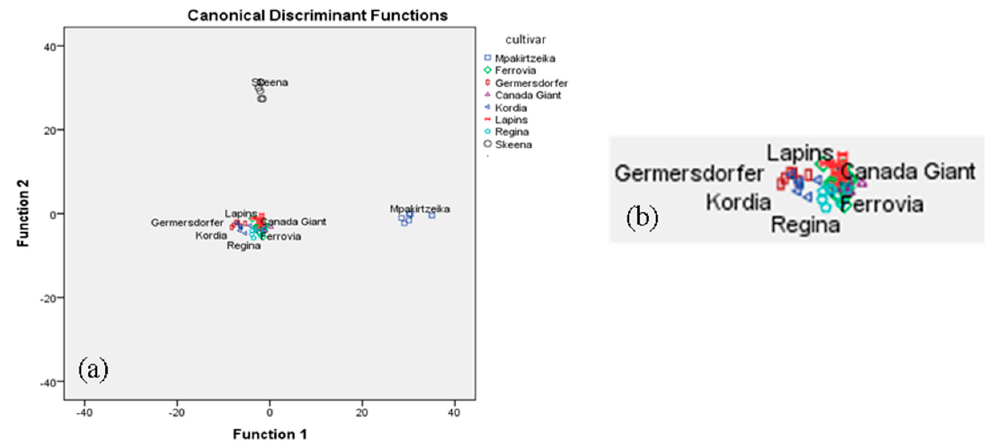
Figure 4. ( a ) Differentiation of eight cultivars based on the combination of conventional quality parameters, volatiles, and minerals; ( b ) blow up of Figure 4a.